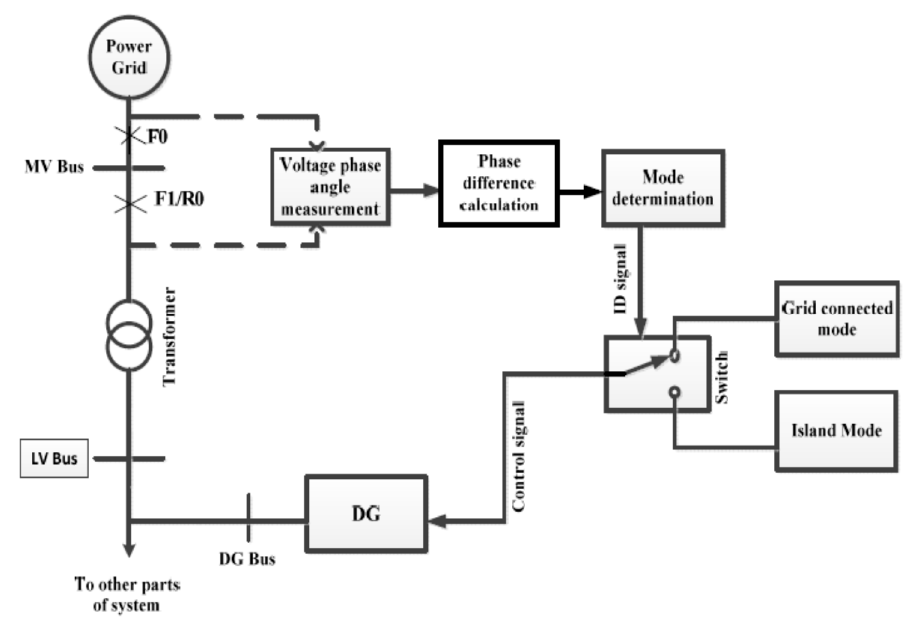
Figure 5. The block diagram of the control mode determination.